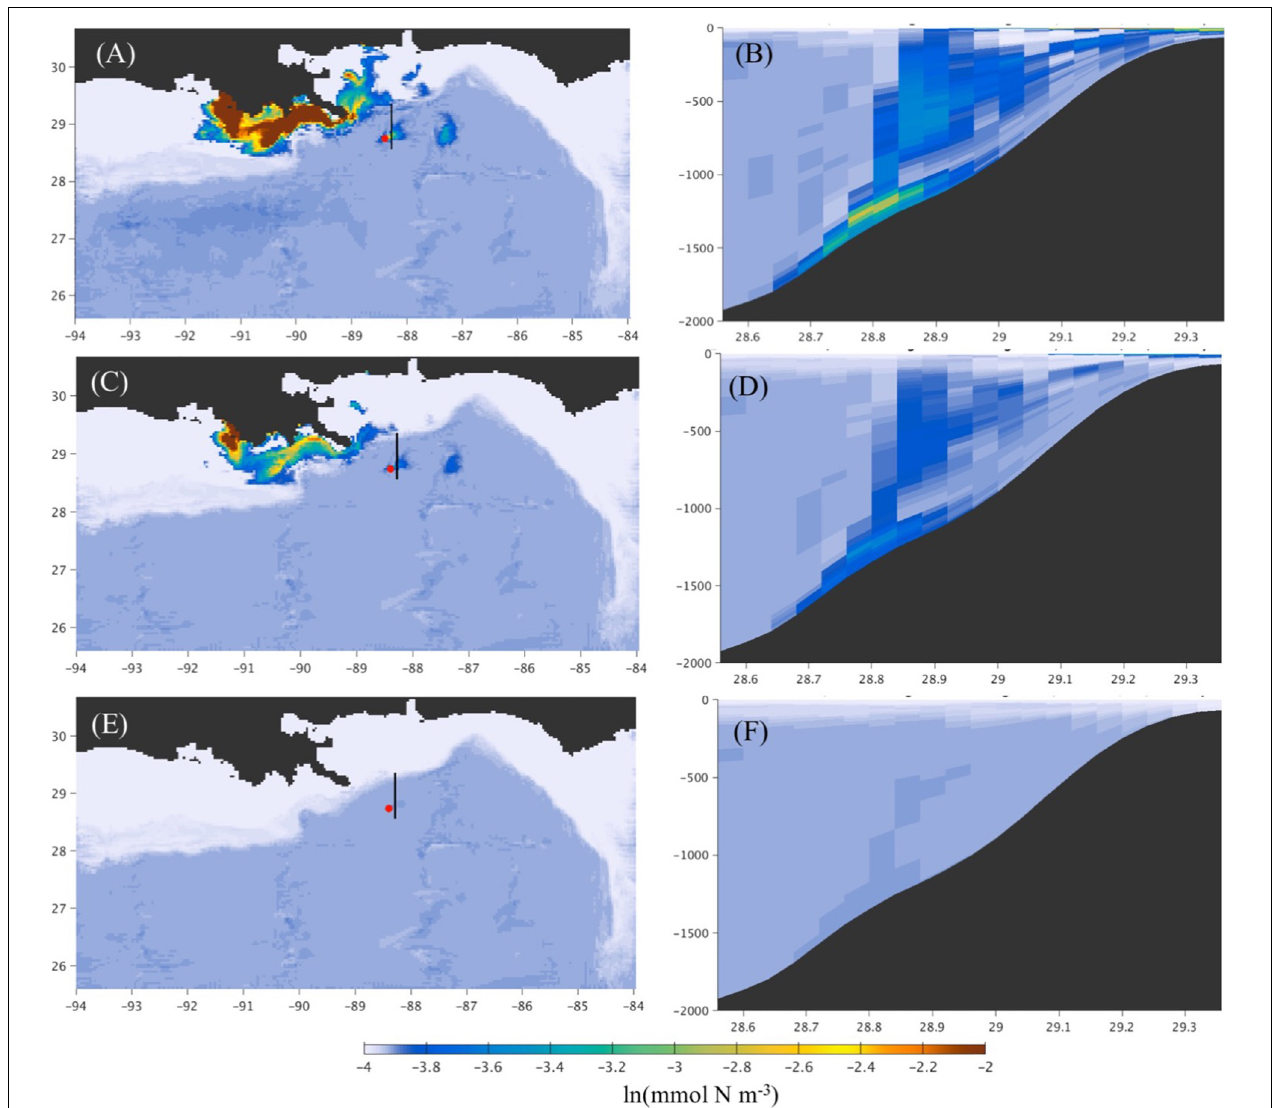
FIGURE 10 | Dissolved bacteria concentration (mmol N m − 3 ) from the test experiment with the fully coupled ROMS-OTWM-OPAMOD-Bgeochemical model after 30 days of simulation. (A,C,E) Spatial distribution of bacteria 2 (saturates), 3 (aromatics), and 4 (heavy oil), respectively, in the near-bottom layer (5th layer from the bottom). The red dot is the release location of the Lagrangian floats. (B,D,F) are the vertical distribution of bacteria 2, 3, 4 concentration along the section indicated with the black line in the left figures. Plots are in the natural logarithmic